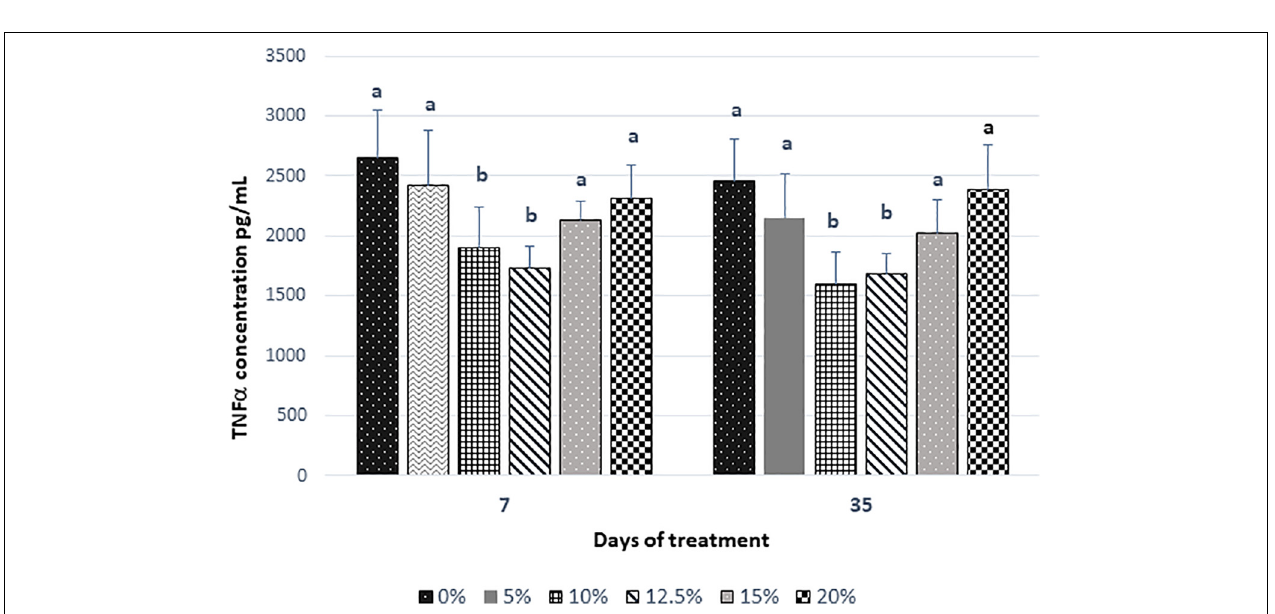
FIGURE 5 | The serum concentration of TNF- α of rats fed for 35 days with Agave salmiana fructans. TNF- α , tumor necrosis factor- α .